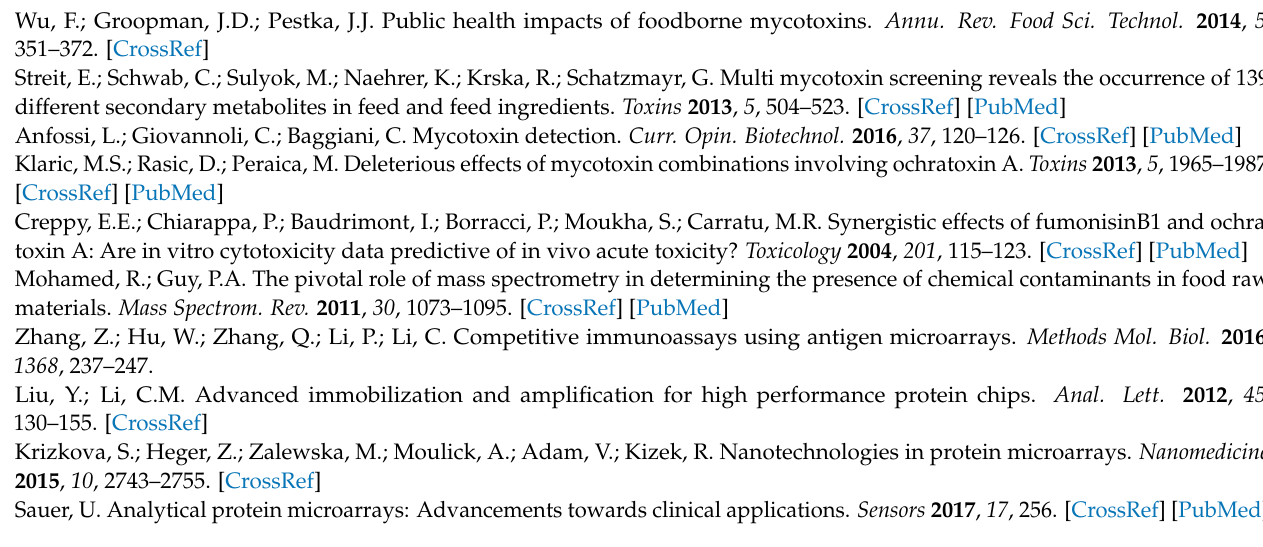
values obtained from Ag-3D slides spotted with 25 µ g/mL of FB1-OVA, 50 µ g/mL of AFB1-BSA, 200 µ g/mL of OTA-OVA, and 100 µ g/mL of DON-OVA versus the anti-mycotoxin antibody concen- tration. Black squares correspond to FB1, red circles to AFB1, blue up triangles to OTA, and green down triangles to DON. Each point is the mean value of 16 spots ± SD, Figure S4. Fluorescence intensity values received using secondary antibodies either fluorescently labeled (orange bars) or biotinylated in combination with fluorescently labeled streptavidin (purple bars). The primary immunoreactions duration was 1 h in all cases. Each point is the mean value of 16 spots ± SD, Figure S5. Fluorescence intensity values versus the reaction time with the biotinylated secondary antibodies. Orange bars correspond to FB1, green bars to AFB1, purple bars to OTA, and yellow bars to DON. The primary immunoreactions’ duration was 1 h in all cases and the reaction with the fluorescently labeled streptavidin lasted 15 min. Each point is the mean value of 16 spots ± SD, Figure S6. Fluorescence intensity values versus the primary immunoreactions’ duration. Orange bars correspond to FB1, green bars to AFB1, purple bars to OTA, and yellow bars to DON. The reaction time with the biotinylated secondary antibodies was 45 min and with the fluorescently labeled streptavidin 15 min. Each point is the mean value of 16 spots ±